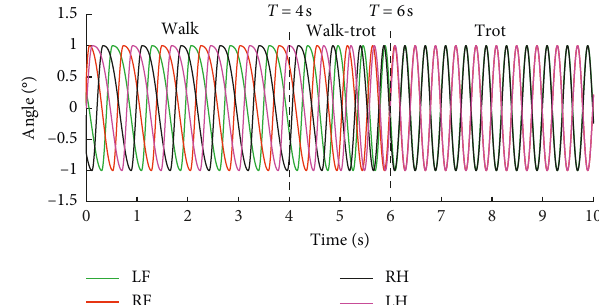
Figure 16: Phase relationship of the hip joint in gait switching for walk-trot.